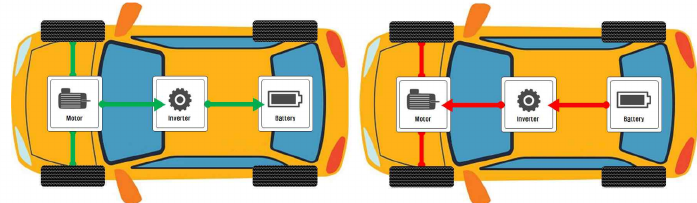
Figure 2. Comparison of regenerative braking and discharging